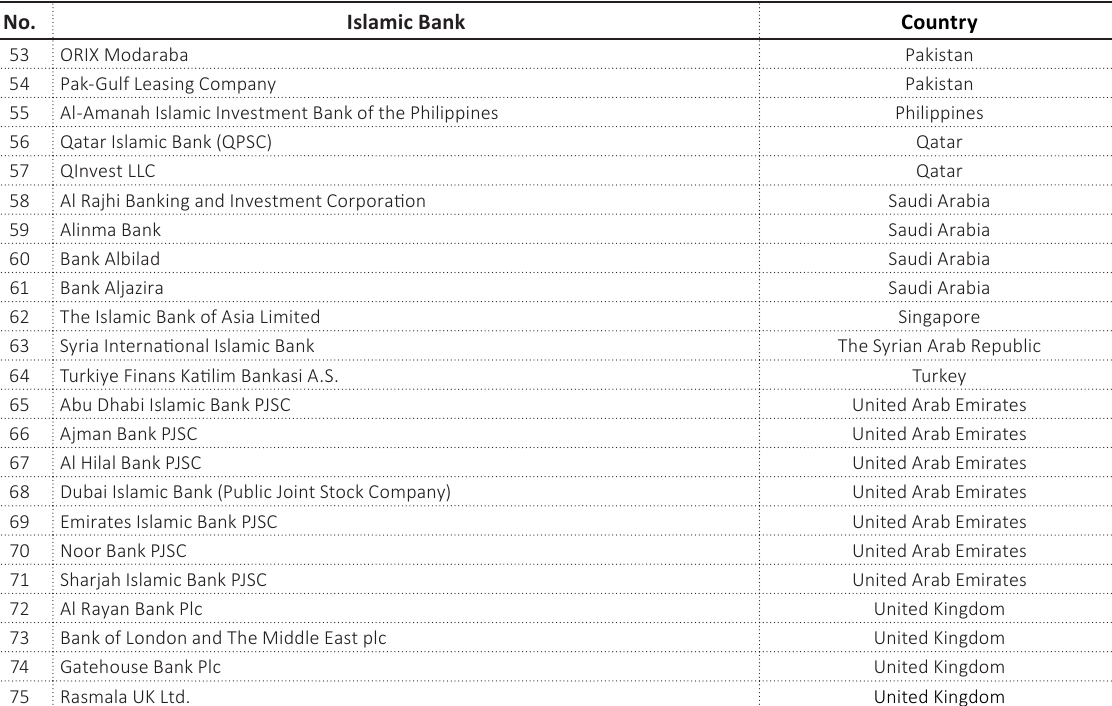
Table A1 (cont.). List of sample Islamic